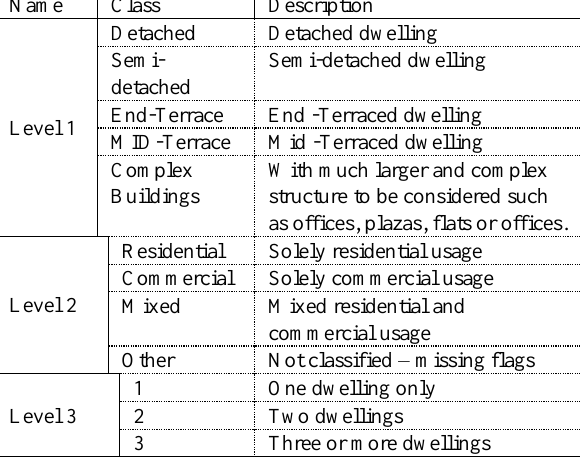
Table 2. A three levels classification hierarchy for buildings